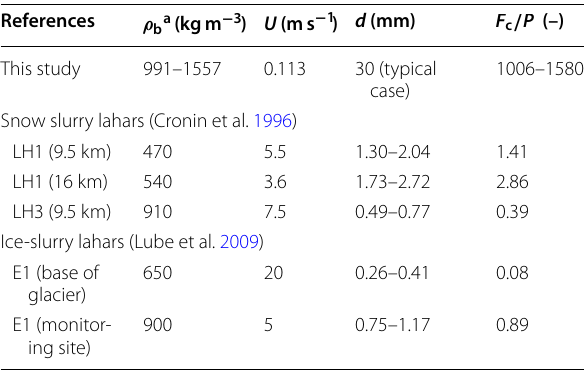
Table 2 Summary of scaling analysis